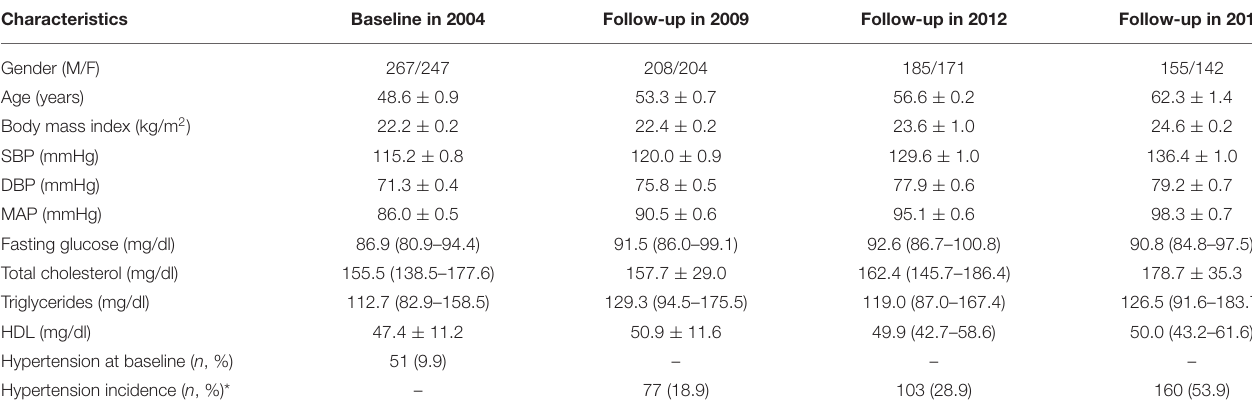
TABLE 1 | Characteristics of the study participants at baseline and during follow-ups.